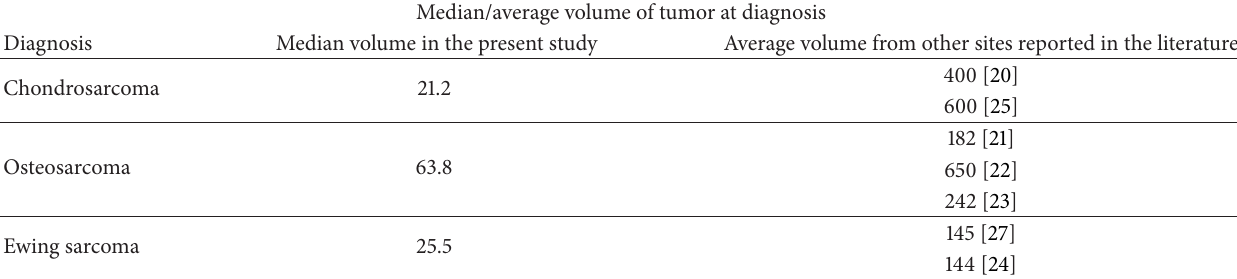
Table 4: Average volume of tumors in the foot and at other anatomical